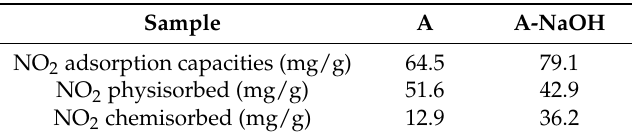
Table 4. Chemisorbed, physisorbed and total amounts of NO 2 adsorbed at the surface of the activated carbons treated or not with NaOH.